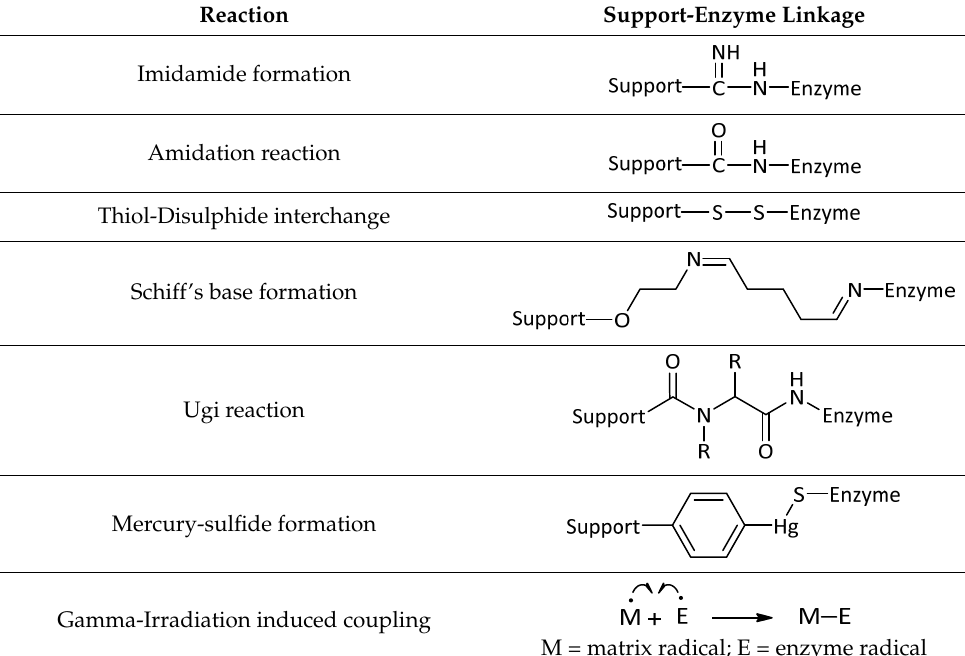
Table 2. Different methods for covalent binding of enzymes to supports [35,111–114].